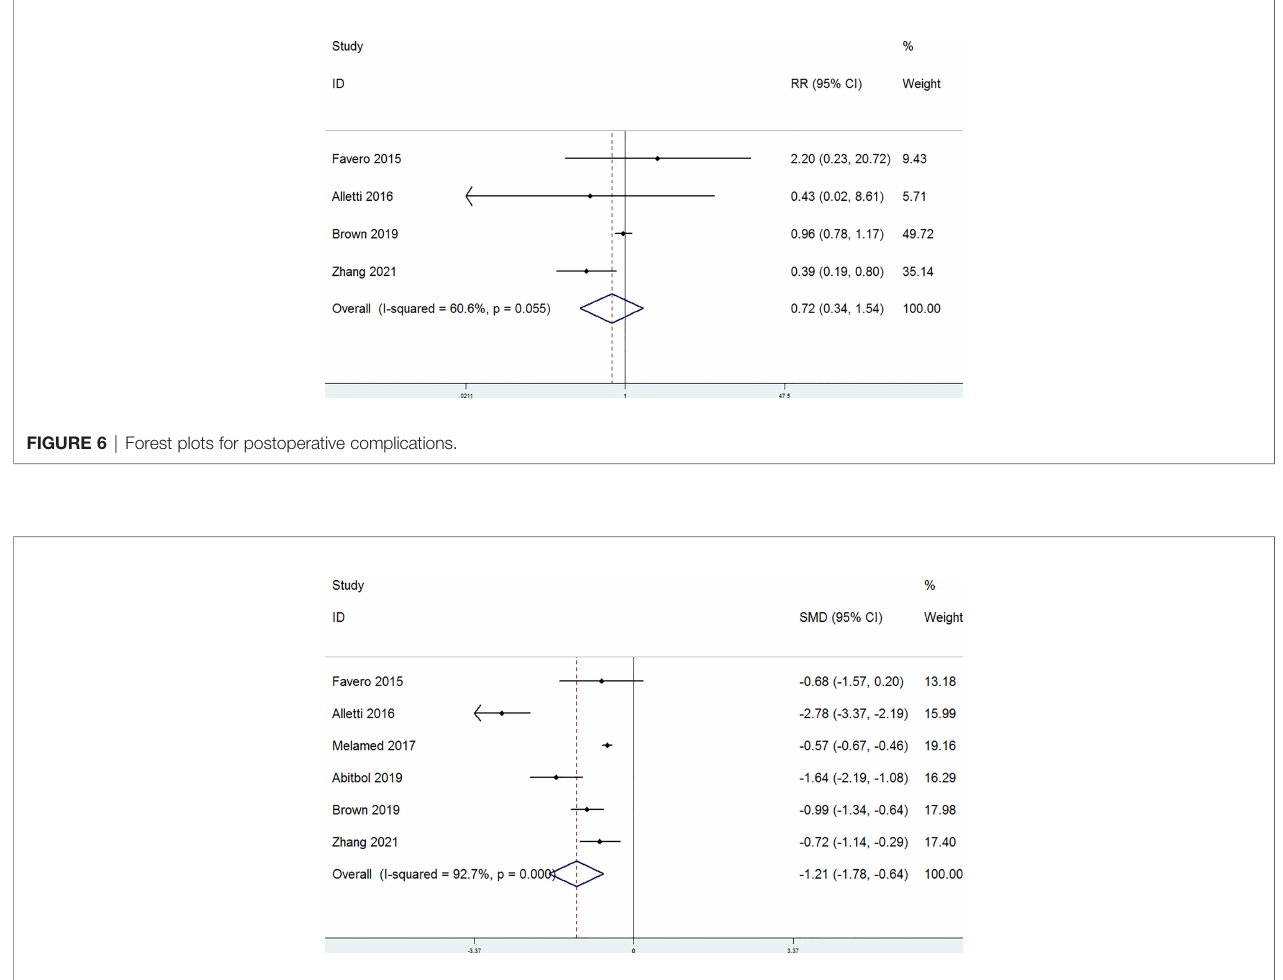
FIGURE 7 | Forest plots for the length of stays in